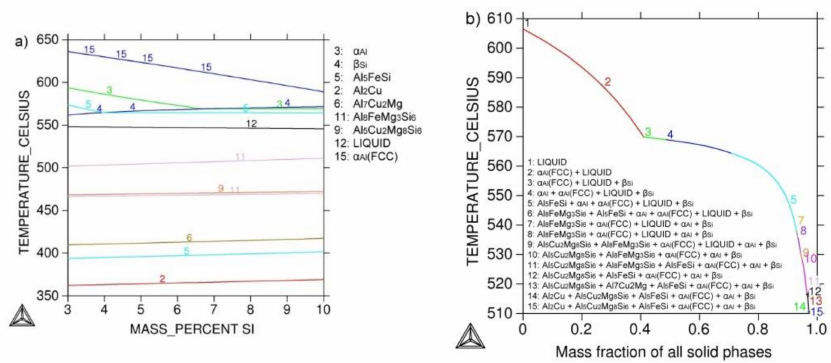
Figure 2. Modelling of solidification sequence of AlSi7MgCu alloy: ( a ) part of equilibrium Al-Si phase diagram, ( b ) Scheil–Gulliver non-equilibrium phase diagram.